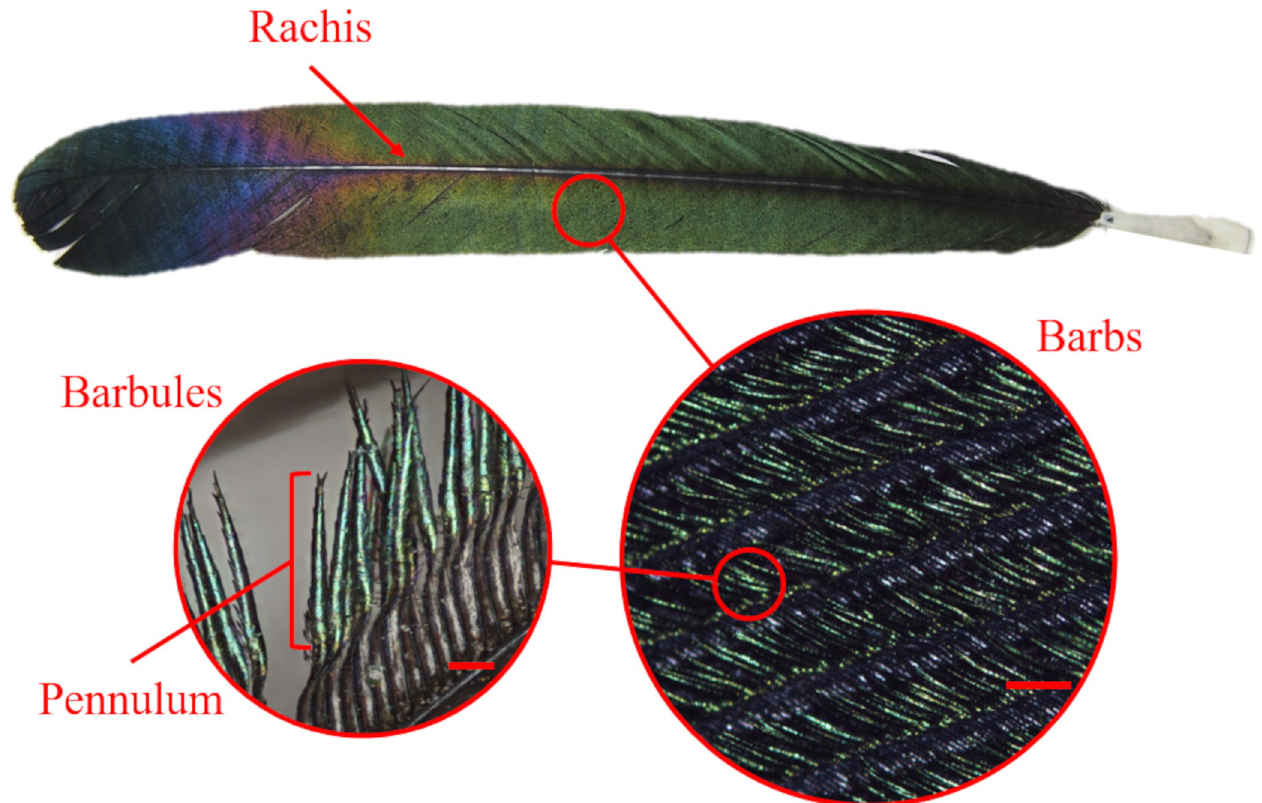
Fig 1. Photographs and microscopic details of the uppermost tail feather of the Oriental magpie ( P . serica ). The tail feather of the magpie was observed using an optical camera. The barbs extend from the rachis, and the barbules reach out from the barbs in succession. The surface of the flattened and elongated parts (pennulum) of the distal barbules is iridescent green, transforming into iridescent violet and navy around the tip of the feather. The scale bars in left and right represent 50 μ m, 200 μ m, respectively.